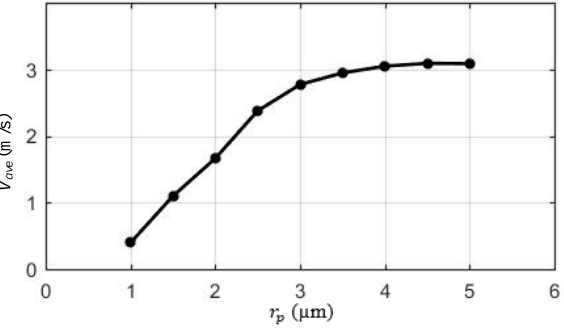
Figure 9 Relationship between average flushing speed and particle radius.